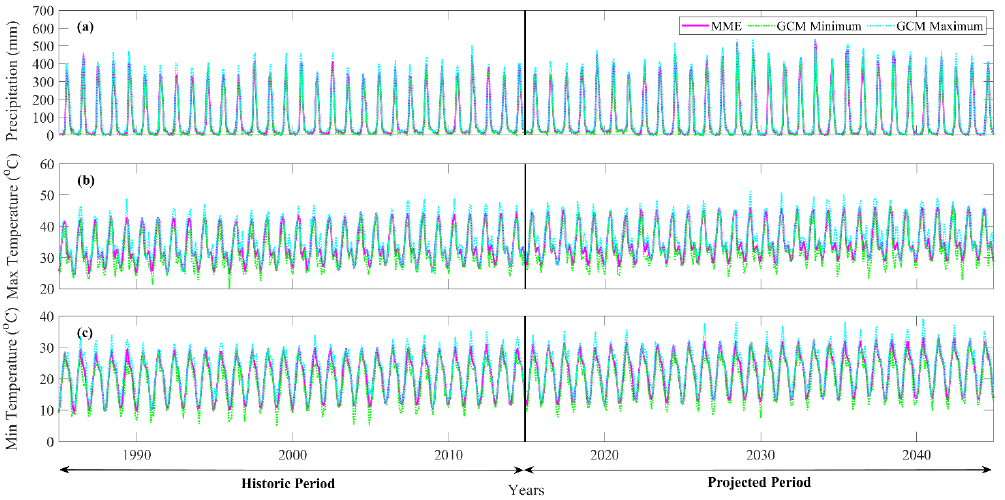
Figure 3. Time series of maximum and minimum values of GCM and the MME mean for the Bundelkhand region (BK). ( a ) Precipitation; ( b ) maximum temperature; ( c ) minimum temperature.